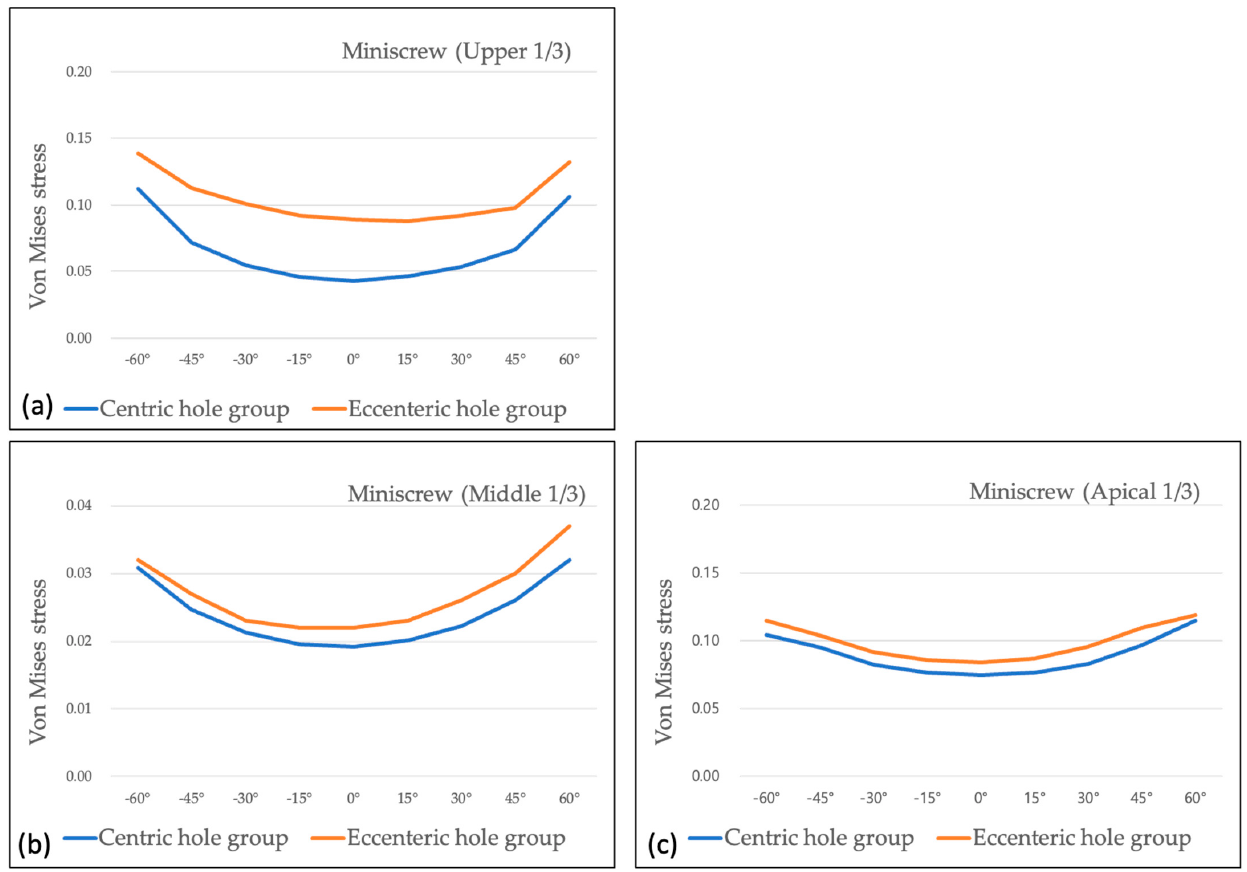
Figure 8. Maximum Von-Mises stress under 1 ◦ of counter-clockwise rotation at each part of the miniscrew: ( a ) Von-Mises stress at the upper 1/3 of the miniscrew showing relatively high value in the eccentric hole group and in the negative angles; ( b ) Von-Mises stress at the middle 1/3 of the miniscrew; ( c ) Von-Mises stress at the apical 1/3 of the miniscrew.